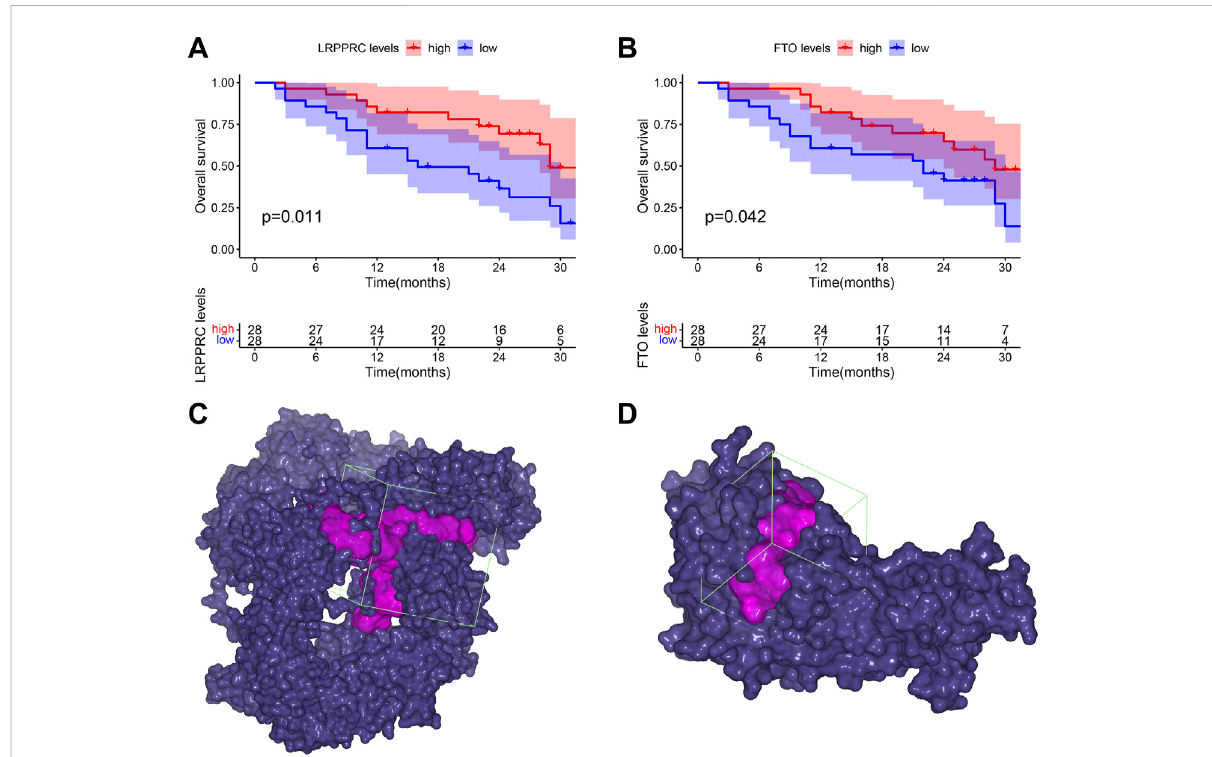
FIGURE 10 Clinical prognosticvalueofLRPPRC andFTOinIPFandtheirbindingpocketsfor virtual screening. (A) Kaplan-Meiersurvivalcurveoftheoverall survival in high and low LRPPRC expressions subgroups. (B) Kaplan-Meier survival curve of the overall survival in high and low FTO expression subgroups. (C) Binding pocket of LRPPRC: core of pocket ( − 15.83, 4.206, 9.538) Å, size of pocket (40, 40, 40) Å. (D) Binding pocket of FTO: core of pocket (29.199, − 7.339, − 23.371) Å, size of pocket (26, 26, 26)